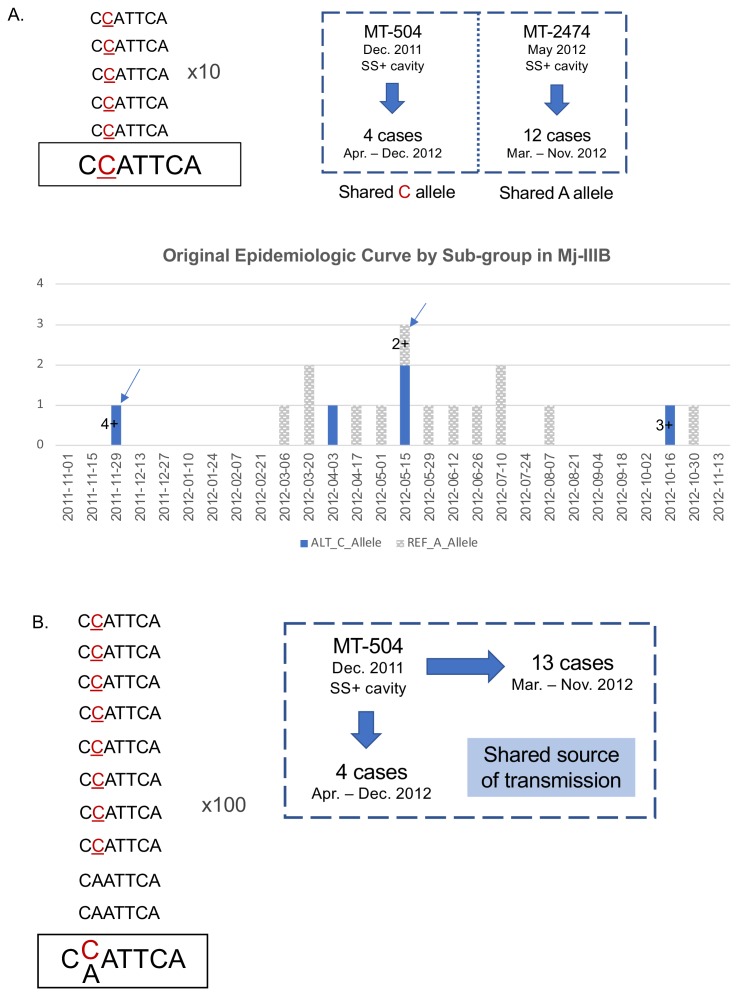
Comparison of epidemiologic inferences using 'routine' versus 'deep' sequencing.(A) Routine sequencing (to ~40–50x) had indicated there were three major clusters present in village K in 2011–2012, Mj-IIIA, B and C. Further analysis of sequencing and epidemiological data indicated that the 2011–2012 cases in Mj-IIIB could be divided into two subgroups of transmission – comprised of five and 13 patients, respectively (Lee et al., 2015b). MT-504 was the suspected source case for the subgroup of five, which all shared a ‘C’ allele at position 276,685 in H37Rv (position 276,544 in MT-0080_PB). In contrast, all members of the subgroup of 13 shared an ‘A’ at this position. Previously, MT-2474 was the suspected source case for this subgroup; this case was the first person with smear-positive (SS+) cavitary disease diagnosed in this subgroup. The epidemiologic curve for the 2011–2012 Mj-IIIB cases is shown, stratified by sub-group based on the alleles detected with routine sequencing. MT-504 and MT-2474, the putative sources within each sub-group are indicated. Sputum smear grade is given where cases were positive on microscopy. Dates of diagnosis are classified into biweekly intervals. (B) In contrast to standard sequencing, deep sequencing data revealed that, in fact, MT-504 – the presumed source for the subgroup of five cases and the first highly contagious case diagnosed in Mj-IIIB during the outbreak year – had both ‘C’ and ‘A’ alleles at this position (563:133 of reads, respectively), suggesting this was in fact the most probable source for both subgroups.